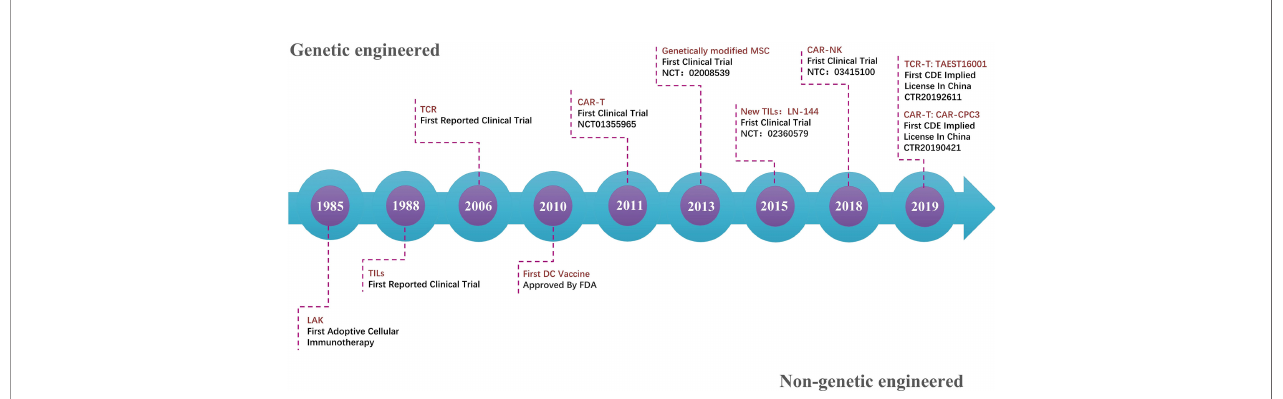
FIGURE 1 | Timeline of important events for cell therapy in solid tumors. After the fi rst adoptive cellular immunotherapy, LAK opened the gate of cell therapy in 1985. Cell therapy has rapidly evolved in the last 10 years with a consistent appearance of novel types. The transformation from the non-genetic engineering model to genetic engineering-based products is the most important